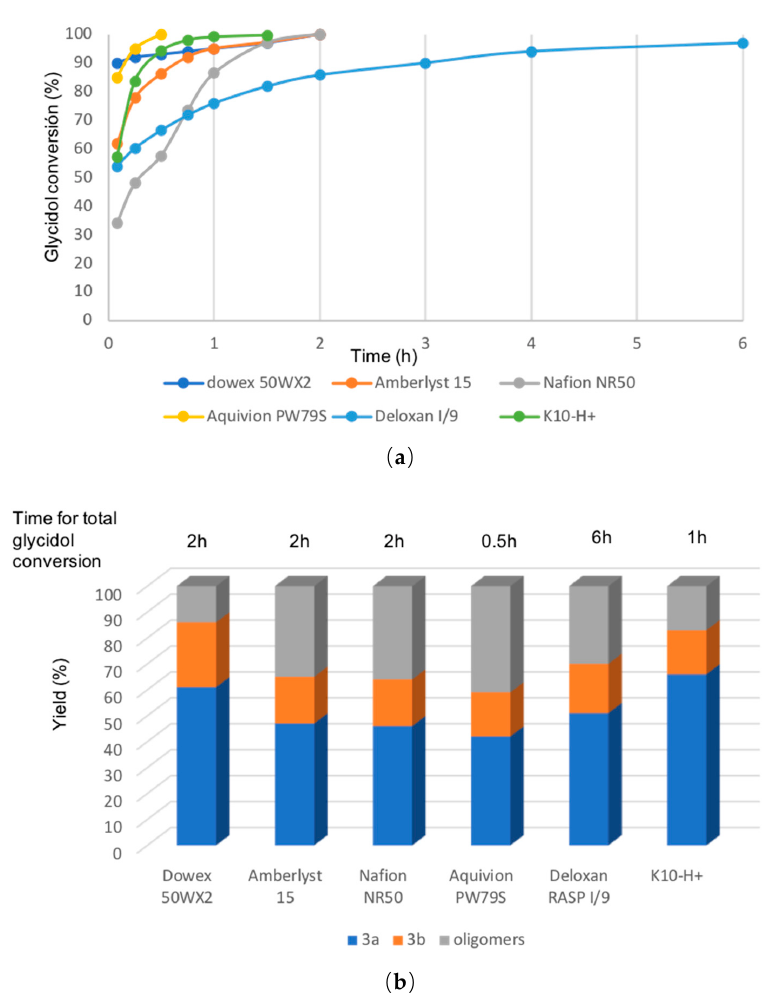
Figure 2. Influence of the nature of the catalyst on glycidol ( 1 ) conversion ( a ) and products selectivity ( b ).